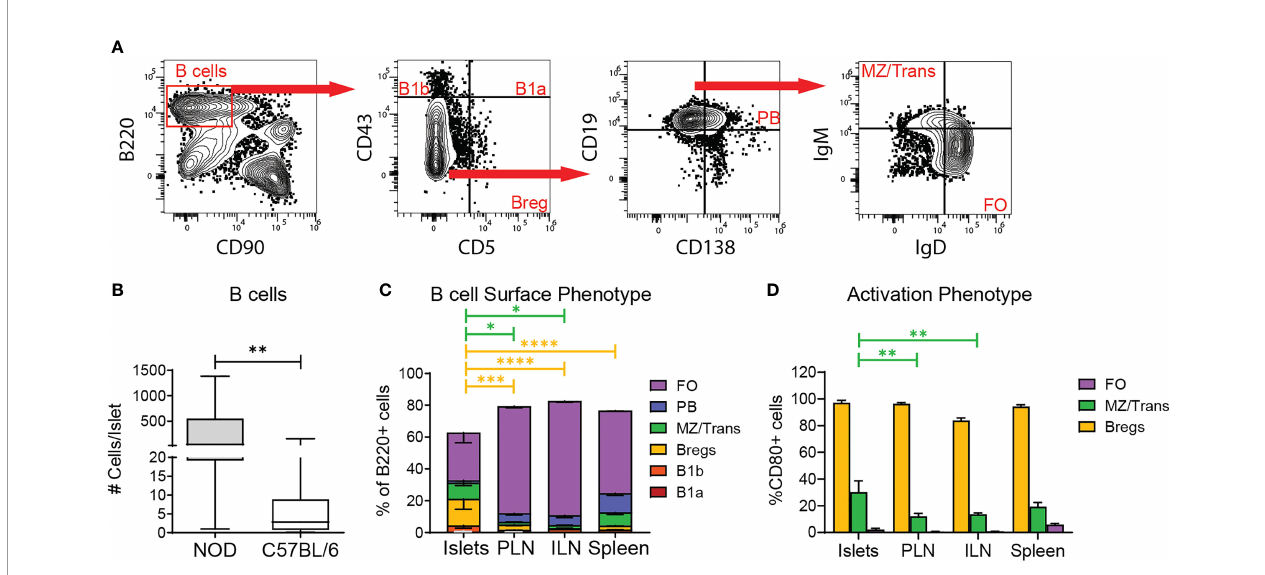
FIGURE 4 | Regulatory B cell subsets are enriched in the islets. (A) Example gating of B cells subsets by fl ow cytometry. (B) Number of B cells per islet. n=57 C57BL/6 mice from 10 independent experiments, n=6 NOD mice from 5 independent experiments. (C) B cell subset composition of B220+ cells by surface phenotype. FO= CD43-CD5-CD19+CD138-IgM low IgD hi ; PB= CD43-CD5-CD19+CD138+; MZ/Trans= CD43-CD5-CD19+CD138-IgM hi IgD low ; Bregs= CD43-CD5+;